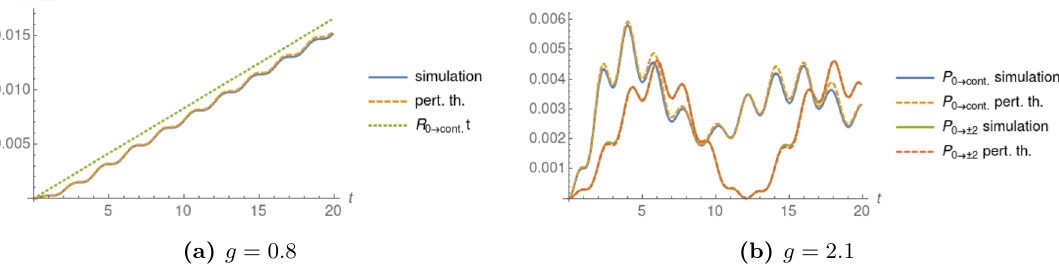
Figure 6. Transition probabilities from the zero mode to continuum and bound states for the toy model. We consider the normal mode case with parameters A = 0 . 1 , γ = 3 . 0 . We compare simu- lation results with first order perturbation theory. The rate from the zero mode to the continuum (eq. (3.3)) is also shown in (a) with dotted